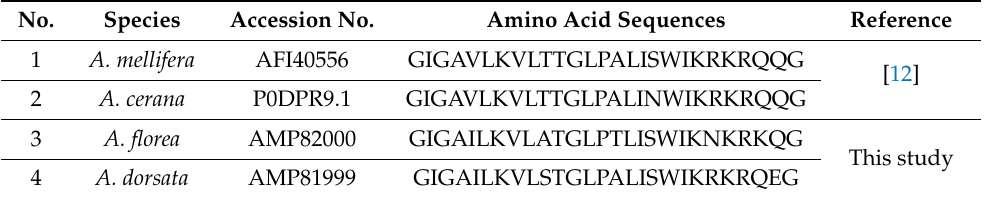
Table 1. Melittin peptide sequences of four honey bee